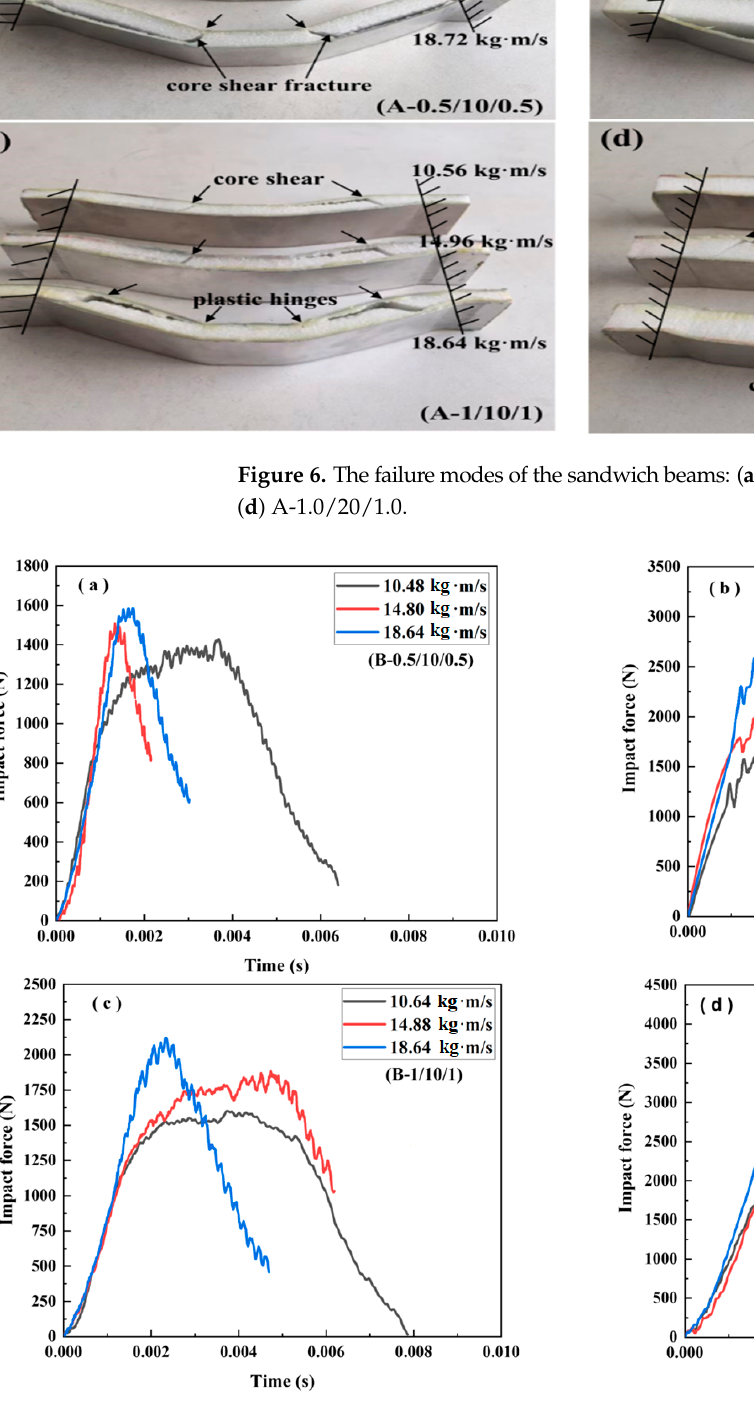
Figure 7. The impact force–time curve of the sandwich beams: ( a ) B-(0.5/10/0.5); ( b ) B-(0.5/20/0.5); ( c ) B-(1.0/10/1.0); ( d ) B-(1.0/20/1.0).